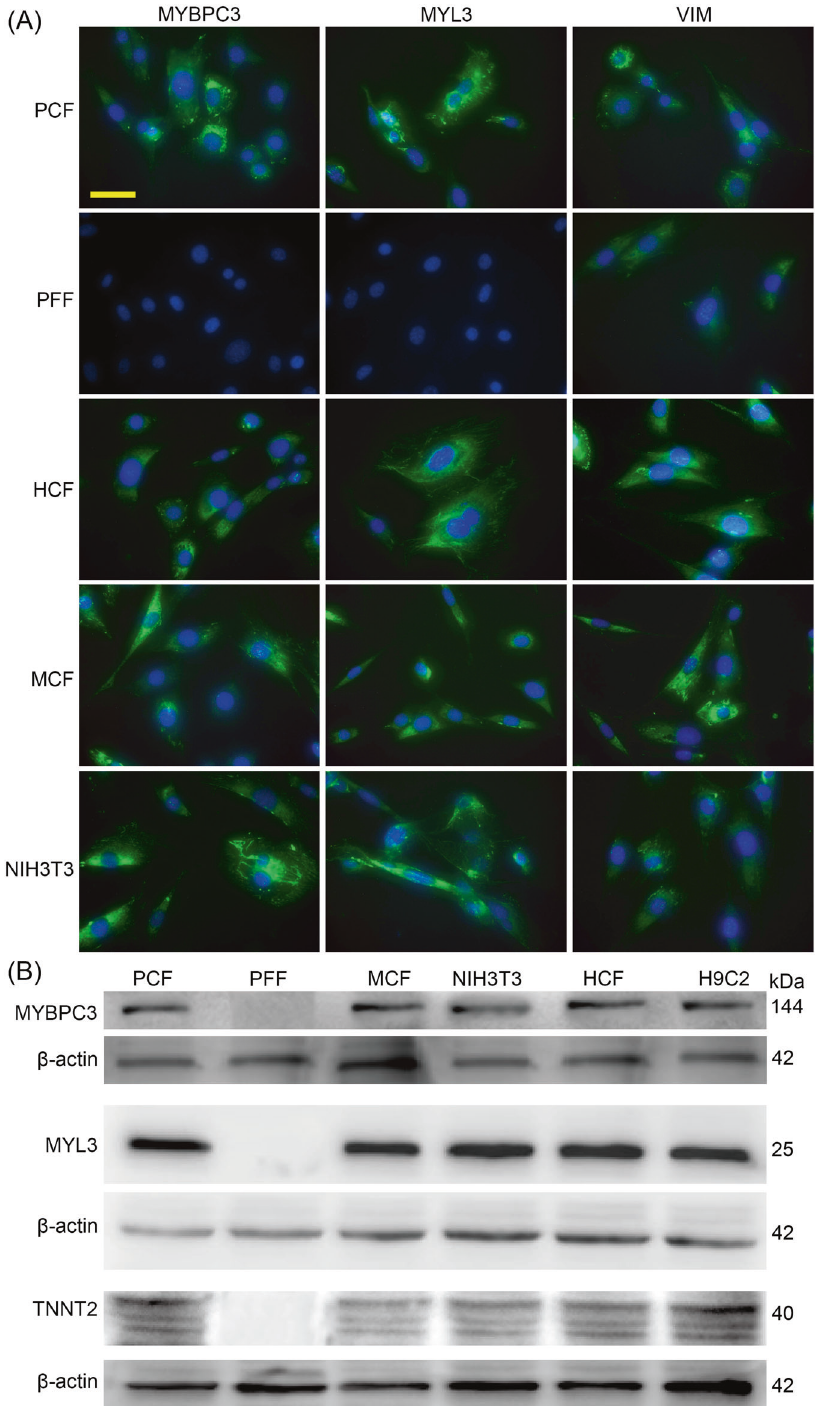
Fig. 2 MYBPC3 and related myocardial proteins are expressed in cardiac fi broblasts of various species and NIH3T3 cells. A Immuno fl uorescence staining of MYBPC3, MYL3, and VIM in primary cardiac fi broblasts from pig (PCF), human (HCF), and mouse (MCF), as well as NIH3T3 fi broblasts. MYBPC3 and MYL3 were found to be negative in porcine fetal fi broblasts (PFF). B Western blot analysis of MYBPC3, MYL3, TNNT2 in various cardiac fi broblasts, PFF and NIH3T3 cells. H9C2 lysate was used as a positive